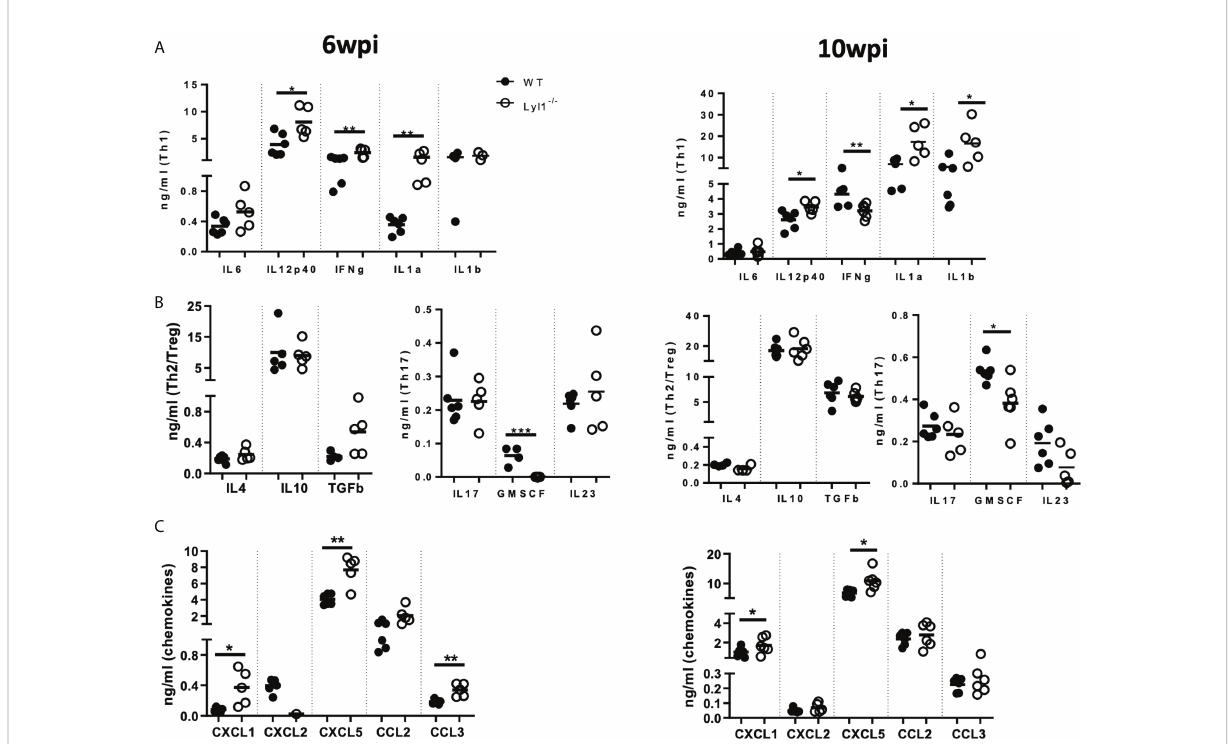
FIGURE 6 Lyl1-deletion promotes in fl ammatory responses during chronic hypervirulent Mtb in vivo . (A-C) Littermate control (WT) and Lyl1 -/- mice were infected with 100 CFU/mouse intranasally with Mtb HN878 ( n = 5 mice/group) and sacri fi ced at either 6- or 10-weeks post-infection. Supernatants from lung homogenates were analyzed by ELISA for (A) Th1, (B) Th2 and T-regulatory cytokines, Th17 cytokines, and growth factors (C) and chemokines. Line denotes Mean. Data shown are representative of 2-3 independent experiments. Unpaired student t-test analysis at * p < 0.05, ** p < 0.01 to determine signi fi